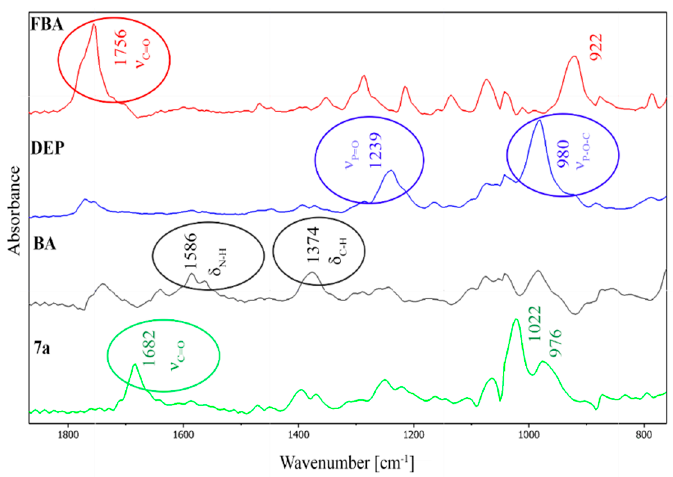
Figure 5. IR spectra of the reaction components obtained after deconvolution.